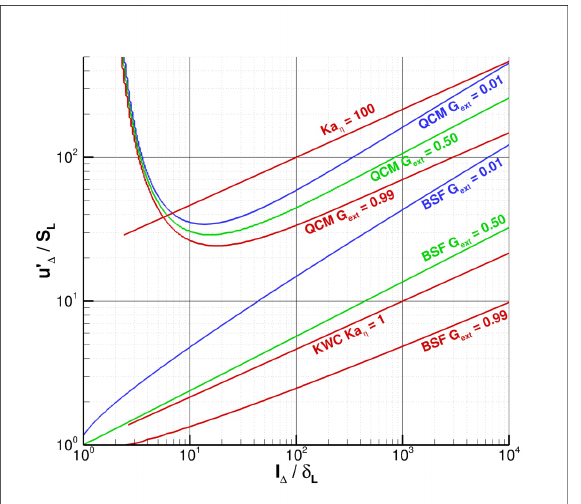
Figure 2. Comparison of the two quenching criteria analyzed. In particular, three G ext isolines are shown on the plane of the standard combustion diagram for both Bray’s stretch factor model (BSF) with Pr = 1 and the quenching cascade model (QCM). The Ka η = 1 line related to the Klimov–Williams criterion (KWC) is also shown for